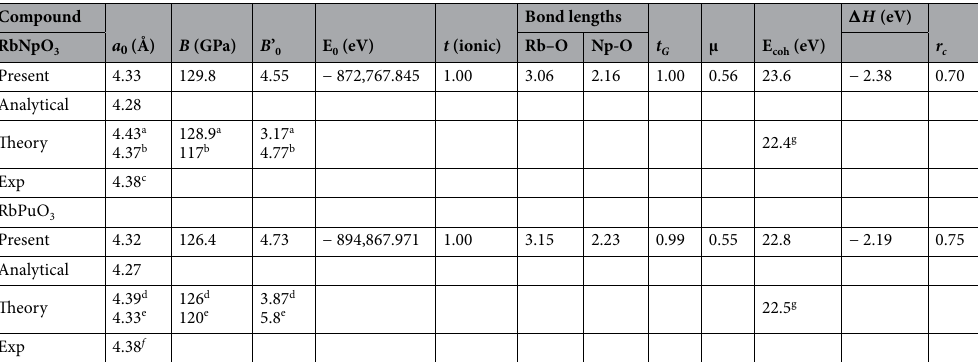
Table 1. Illustrated values of the relaxed lattice parameter ( a 0 ) , bulk modulus ( B ), pressure derivative of bulk modulus ( B ’ 0 ), ground state energy (E 0 ), tolerance factor ( t ), octahedral factor (μ), (cohesive energy (E coh ), energy of formation ( (cid:31) H ) and critical radius (r c ) of cubic RbMO 3 compounds. [a] 24 , [b] 28 , [c] 45 , [d] 25 , [e] 26 , [f] 46 , [g] 13 . The results of other perovskites 13,24–26,28,45,46 are listed for